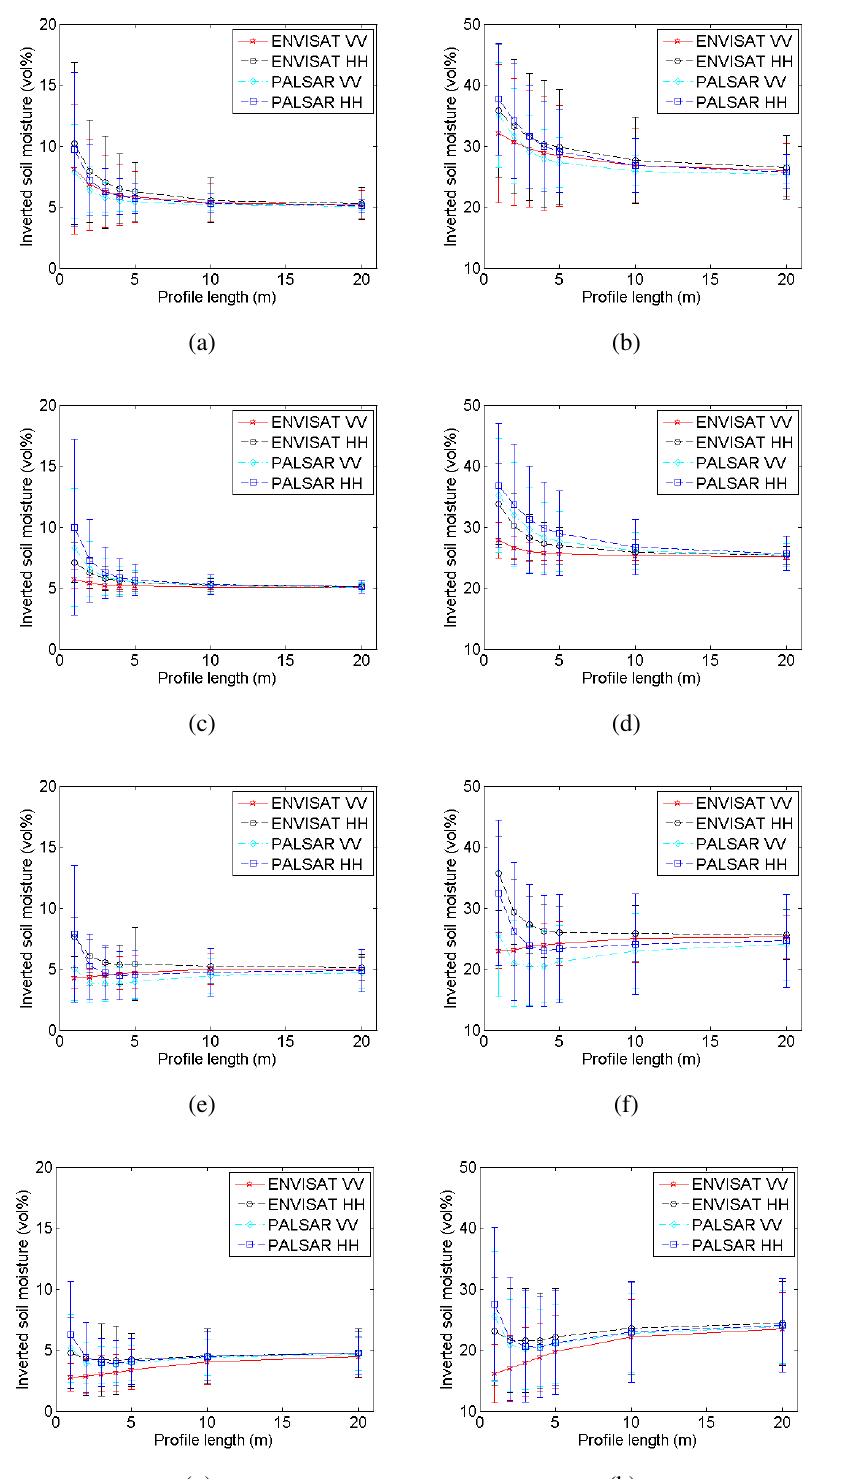
Figure 7. Mean and standard deviations of inverted soil moisture contents for different profile lengths. Inverted soil moisture contents are derived using roughness parameters from sampled profiles, originating from large profiles with ( s , l ) equal to (a), (b) (2 cm,5 cm), (c), (d) (1 cm,5 cm), (e), (f) (2 cm,40 cm) and (g), (h) (1 cm,40 cm), and initial moisture contents of (a), (c), (e), (g) 5 vol% and (b), (d), (f), (h) 25